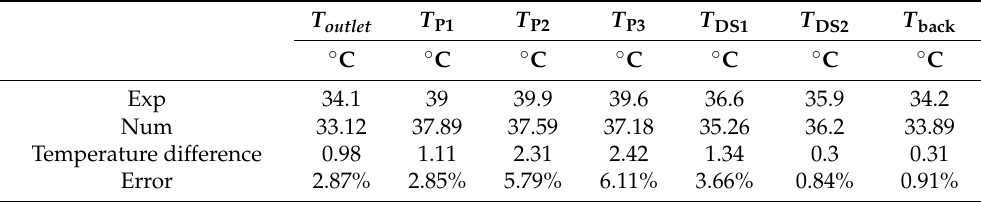
Table 3. Comparison between CFD and experimental